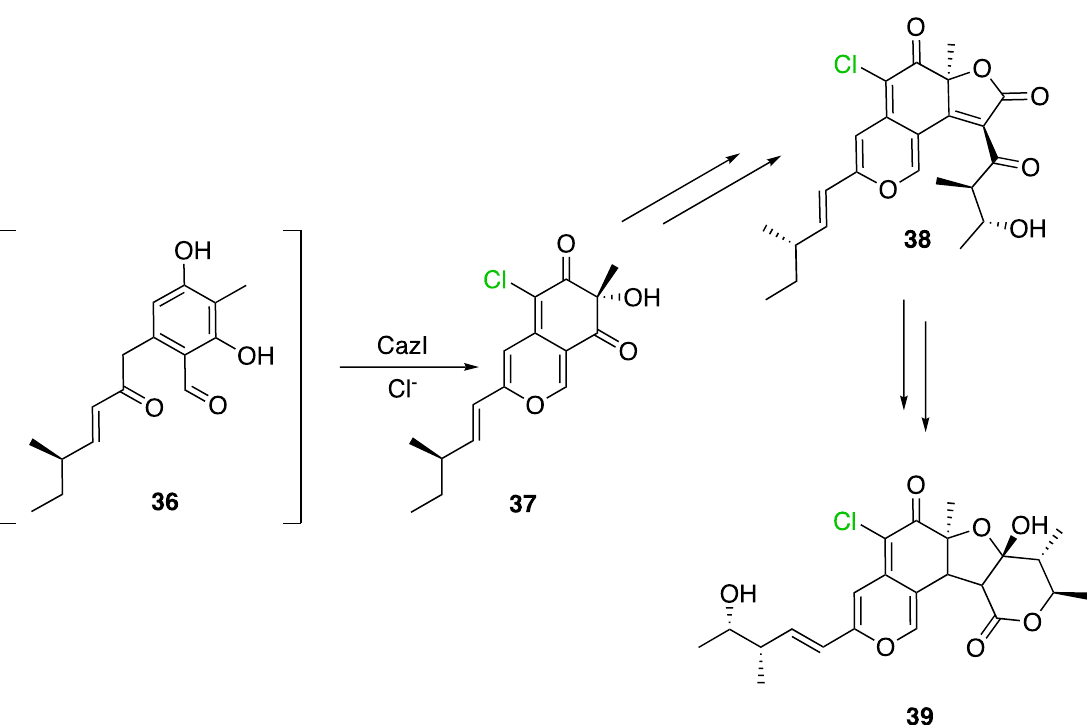
Figure 20. Chlorination of the biosynthetic intermediate ( 36 ) to obtain cazisochromen ( 37 ) in the biosynthetic pathway of chaetoviridin A ( 38 ) and chaetomugilin A ( 39 ). biosynthetic pathway of chaetoviridin A ( 38 ) and chaetomugilin A ( 39 Other Non-Classical Fungal FDHs